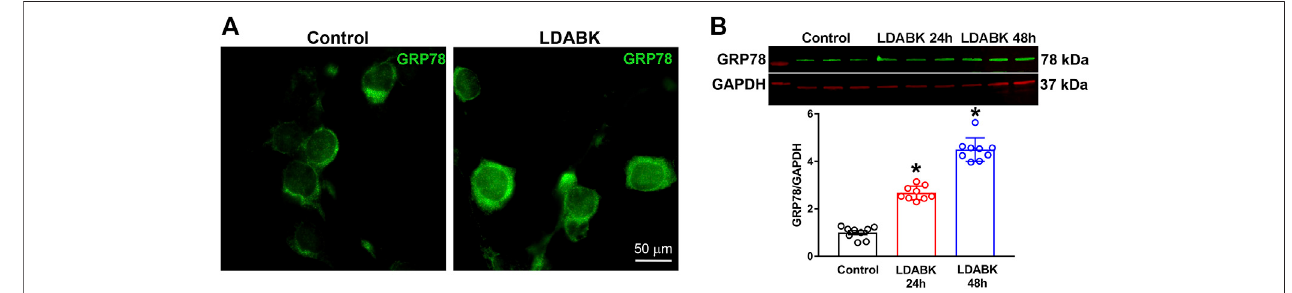
FIGURE 1 | B1R activation increases GRP78 expression in primary hypothalamic neurons. (A) Immuno fl uorescence staining of GRP78 showing treatment with B1R speci fi cagonist, LDABK (300 nM), increased protein expression of GRP78 in primary hypothalamic neurons. (B) Quanti fi cation ofGRP78 protein expression using western blot analysis and quanti fi cation data shows a signi fi cant increase of GRP78 protein expression in LDABK (300 nM) treated neurons compared to vehicle (phosphate buffered saline) treated control neurons. * p < 0.05, compared to control. ( n =